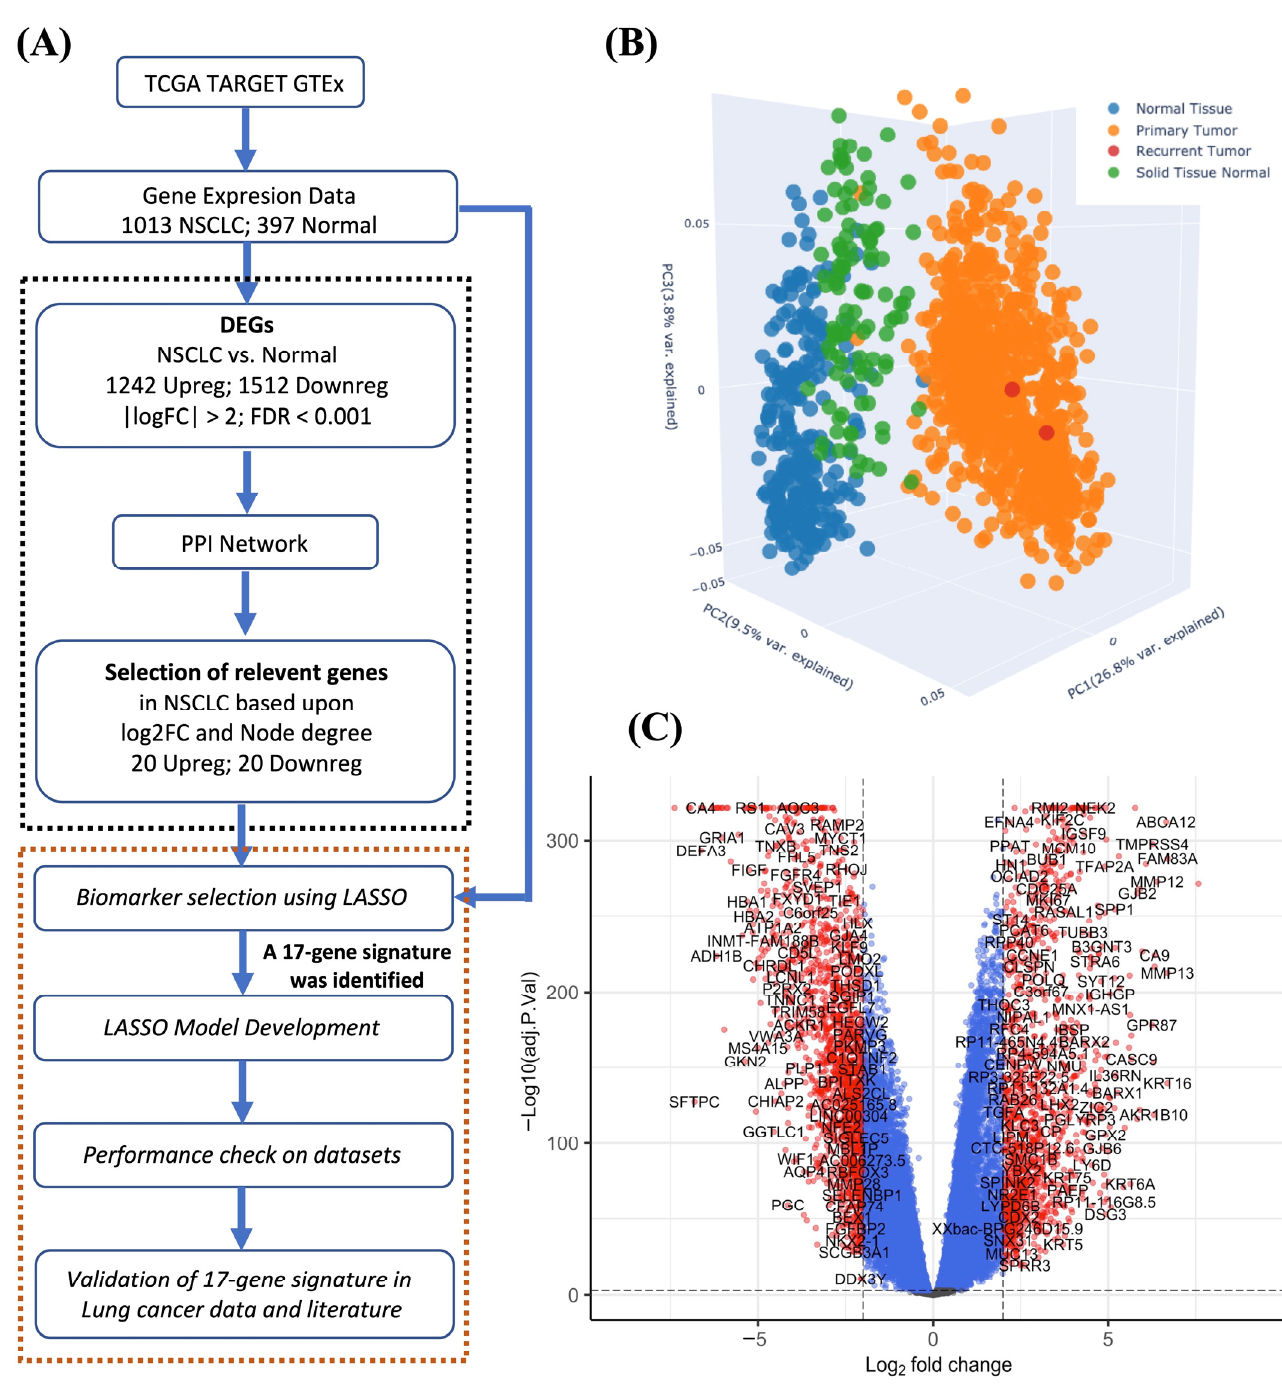
Figure 1. ( A ) Workflow of our study. ( B ) The PCA plot for samples using 2500 genes with the most significant variance. Each point represents the gene expression of a sample. Samples with similar gene expression profiles are closer in the three-dimensional space. ( C ) Volcano plot of DEGs in lung cancer compared with normal samples. The DEGs with |log2FC| > 2.0 and adj.p.val < 0.001 are shown in red.